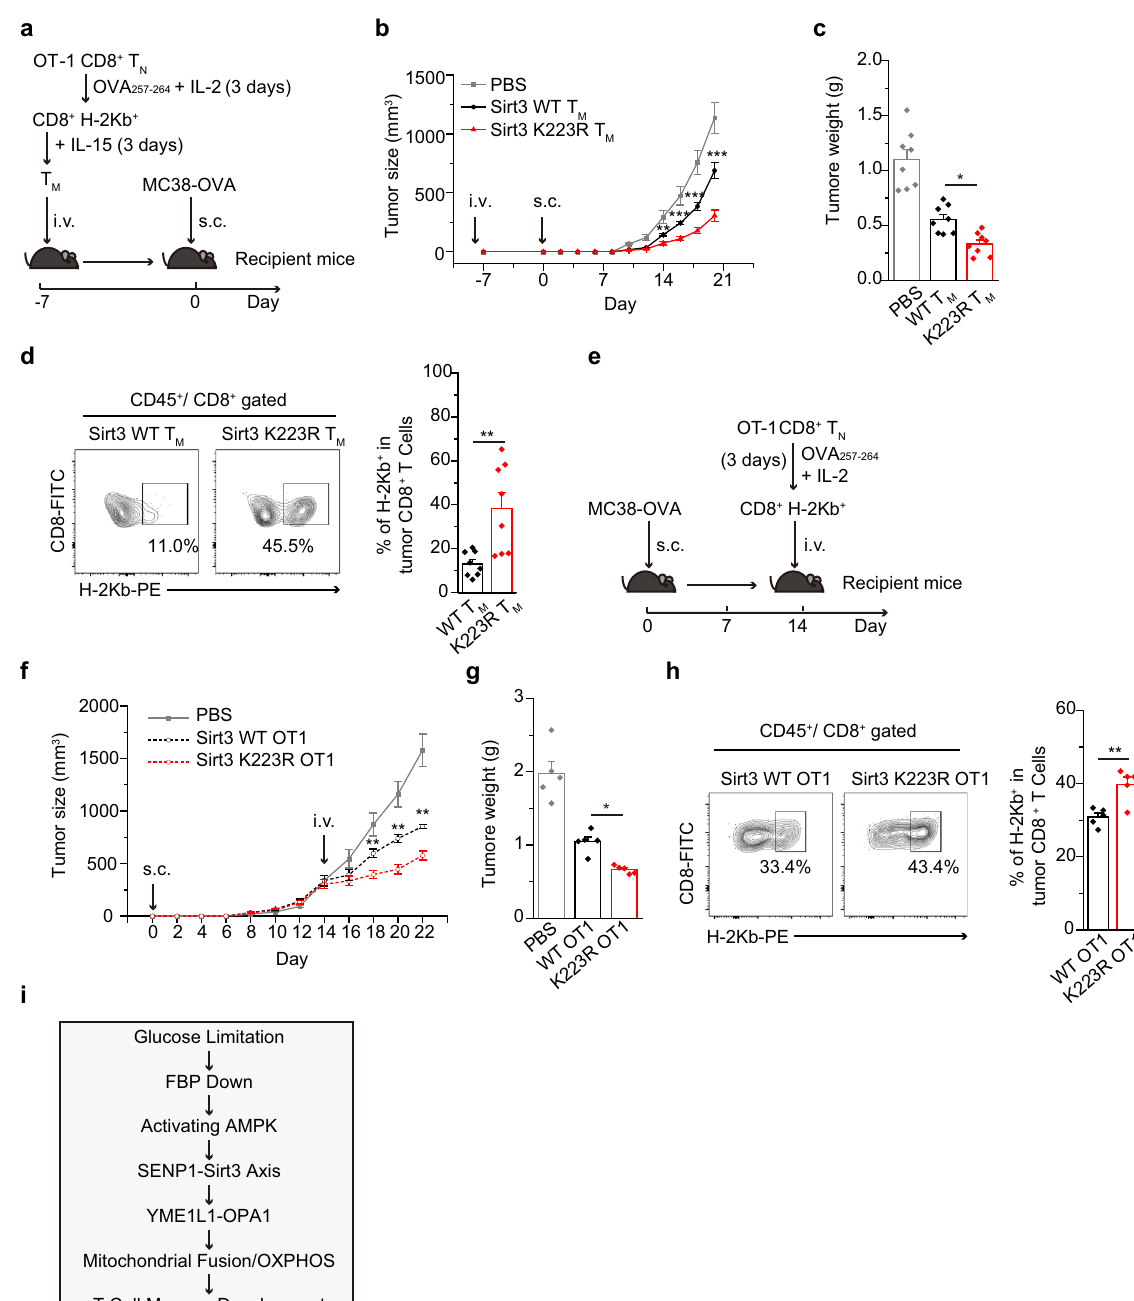
Fig. 6 Sirt3 K223R enhances the anti-tumour immunity of CD8 + T cells. a – d Sirt3 WT or K223R OT1 T M cells (1.5 × 10 6 ) were transplanted into congenic recipient mice (C57BL/6). Seven days ’ post-transplantation, MC38-OVA tumour cells (1.0 × 10 5 ) were subcutaneously inoculated into the recipient mice ( n = 8 mice per group) ( a ). The tumour growth curve is shown in (Two-way ANOVA followed by Fisher ’ s LSD test: ** P = 0.0026, *** P < 0.0001, *** P = 0.0005 and *** P = 0.0007 on day 14, day 16, day 18 and day 20, respectively) ( b ). The tumour weight was measured at day 20 post-injection (One-way ANOVA followed by Fisher ’ s LSD test: * P = 0.021 for Sirt3 WT T M vs Sirt3 K223R WT T M ) ( c ). The frequency of donor CD8 + T cells (H-2Kb + ) in the tumours of the recipient mice was assessed by FACS (Two-tailed unpaired t -test: ** P = 0.0041) ( d ). e – h MC38-OVA tumour cells (1.0×10 5 ) were planted subcutaneously into recipient mice (C57BL/6). OVA 254-264 activated OT1-T cells (1 × 10 7 ) were freshly obtained from Sirt3 WT or K223R OT1 naïve T cells and intravenously (i.v.) transplanted into the above-mentioned mice at day 14 after the injection of tumour cells ( n = 5 mice per group) ( e ). The tumour growth curve was recorded (Two-way ANOVA followed by Fisher ’ s LSD test: ** P = 0.008, ** P = 0.0011 and ** P = 0.0013 on day 18, day 20 and day 22, respectively) ( f ). The tumour volume (mm 3 ) was calculated using the following equation: (length × width 2 )/2. The tumour weight was measured at day 22 after the injection of tumour cells (One-way ANOVA followed by Fisher ’ s LSD test: * P = 0.025 for Sirt3 WT-OT1 vs Sirt3 K223R OT1) ( g ). The frequency of donor CD8 + T cells (H-2Kb + ) isolated from the tumours in the recipient mice was determined by FACS analysis (Two-tailed unpaired t -test: ** P = 0.0047) ( h ). i Model depicting the role of the AMPK-SENP1-Sirt3 axis in regulating FAO-fuelled OXPHOS and mitochondrial fusion in CD8 + T M